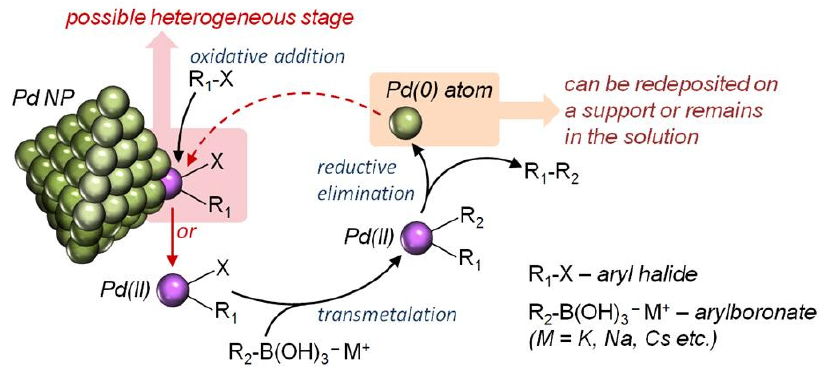
Figure 1. Simplified scheme of Suzuki cross-coupling in the presence of nanoparticulate ligandless catalyst involving both heterogeneous and homogeneous stages.